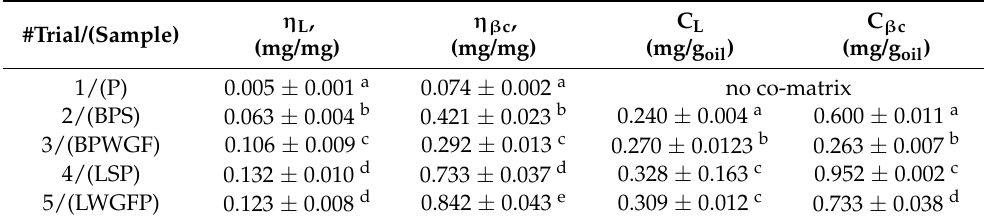
Table 3. Lycopene and β -carotene extraction yields ( η L and η β c ) and lycopene and β -carotene concentrations, C L and C β c , reached in tomato seed and wheat germ flour oils after 2 h extractions.